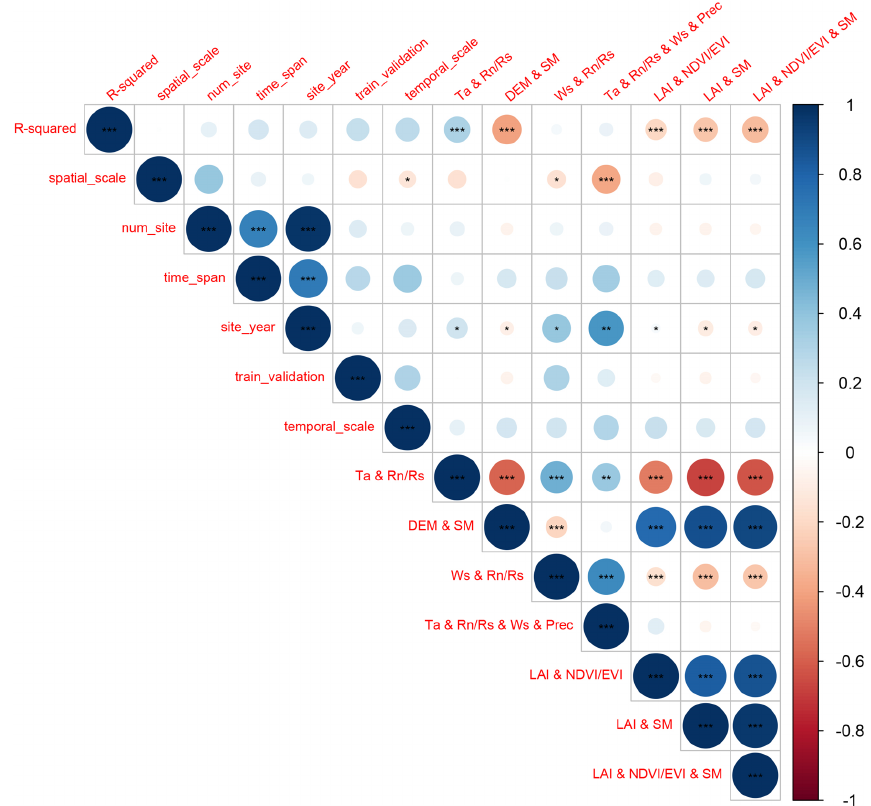
Figure 7. Evaluation of linear correlations between multiple features and the R -squared records with the statistical significance test. For the spatial scale feature , the local scale was set to 1, the regional scale was set to 2, and the global scale was set to 3 in the analysis of linear correlation. For the use of various predictor combinations with “&”, the value for “used together ” is set as 1, and other conditions are set as 0 (e.g., for the T a & R n /R s & W s & P feature, if T a , R n /R s , W s , and P were used together in the model, the value is set as 1). Significance: the p value < 0.01 ( ∗∗∗ ), 0.05 ( ∗∗ ), and 0.1 ( ∗